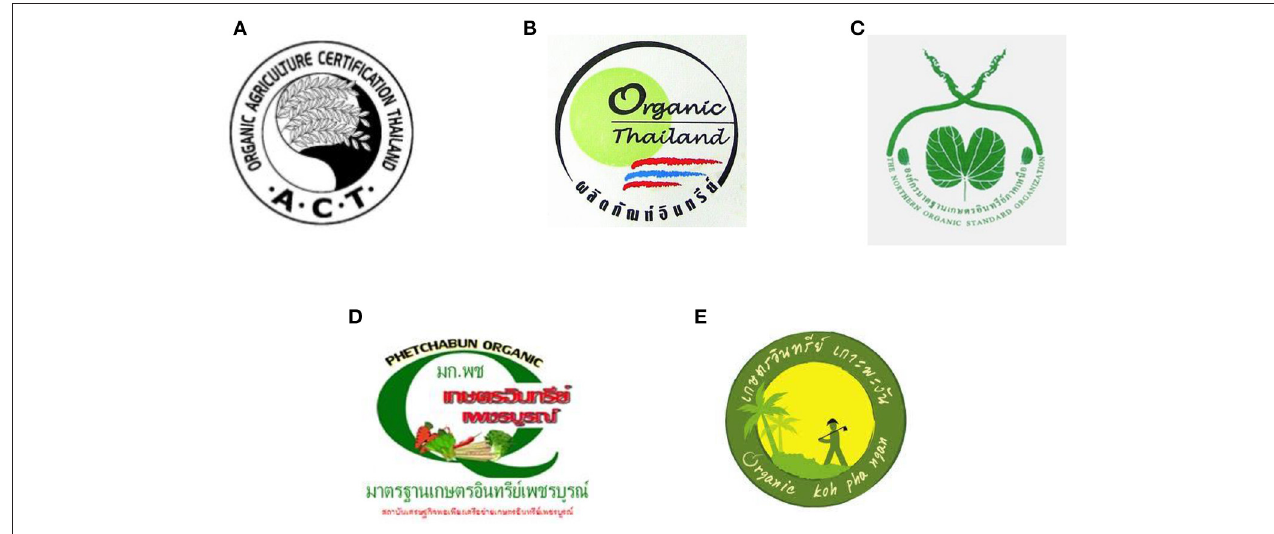
FIGURE 1 | Examples of agricultural certification standards in Thailand.